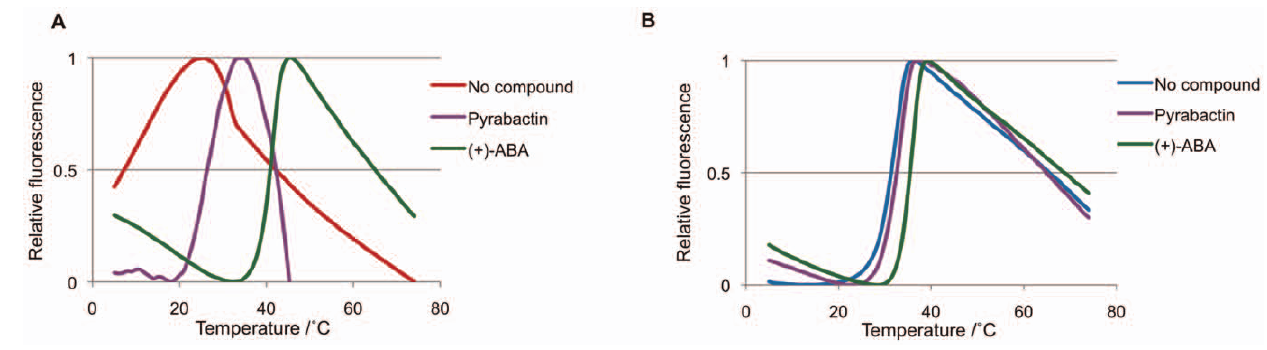
Figure 4. PYL receptor binding of ABA and pyrabactin. ( A + B ) Melt curves of PYL2 ( A ) and PYL1 ( B ) in the absence and presence of 500 m M of ( + )-ABA and